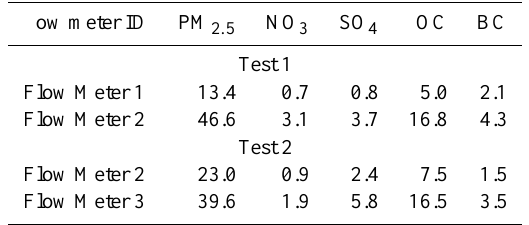
Table 3. Results of simultaneous filter samples showing aerosol mass concentrations ( µ g/m 3 ) determined using one of the three flow meters on the research aircraft. Flow Meter 2 had a reason- able calibration, while Flow Meters 1 and 3 were miscalibrated.